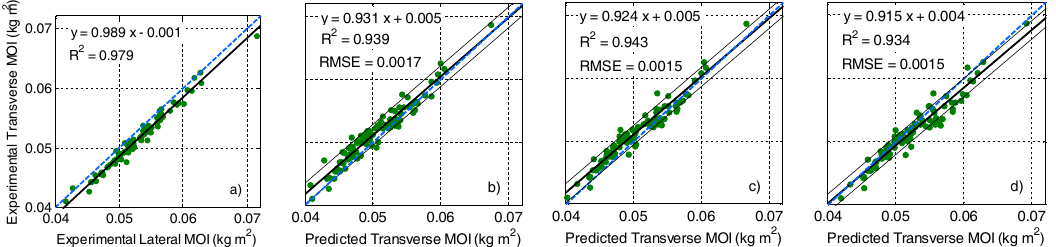
Figure 2. ( a ) Transverse versus Lateral MOI, experimental Transverse MOI versus; ( b ) two-section beam; ( c ) unequal two-section beam and ( d ) five-section